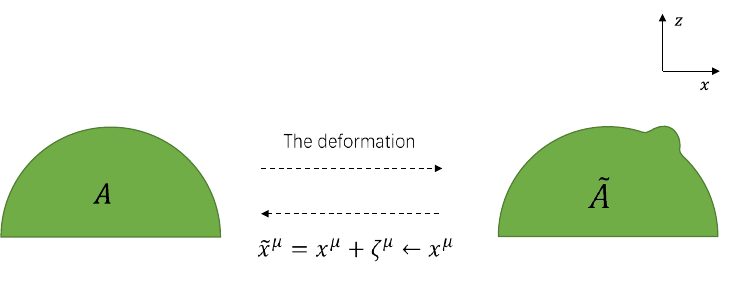
Figure 6 . Relating shape deformation to metric deformation via a corresponding